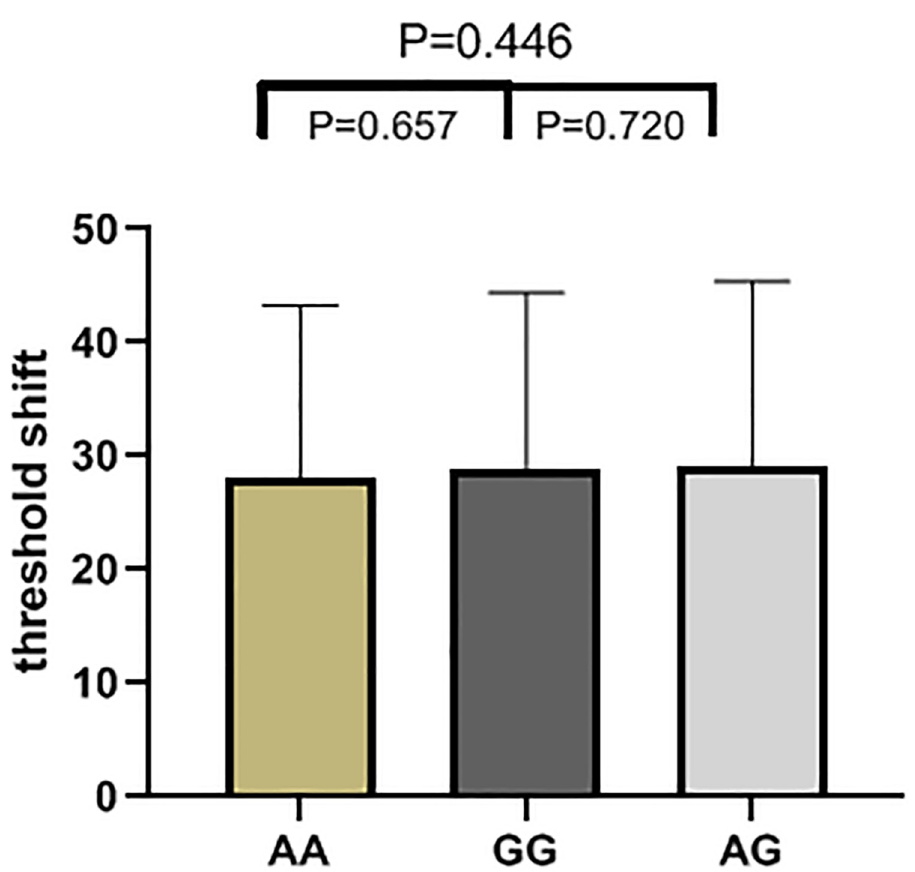
Fig 5. The genotypic distributions of rs9485372. The height of each column is the value of hearing threshold and each column stands for 1 genotype. https://doi.org/10.1371/journal.pone.0251090.g005 of tRNA respectively [32, 33]. In the immune system, TAB2 plays a role on mediating in the IMD signaling pathway and takes on a great responsibility for the response to bacterial and viral infection [34]. Remarkably, rs521845 is located in synonymously coding region of TAB2, of which mutations may have a certain clinical significance. Mutations in synonymous codons are known to be linked with human diseases by affecting other features of protein biosynthesis